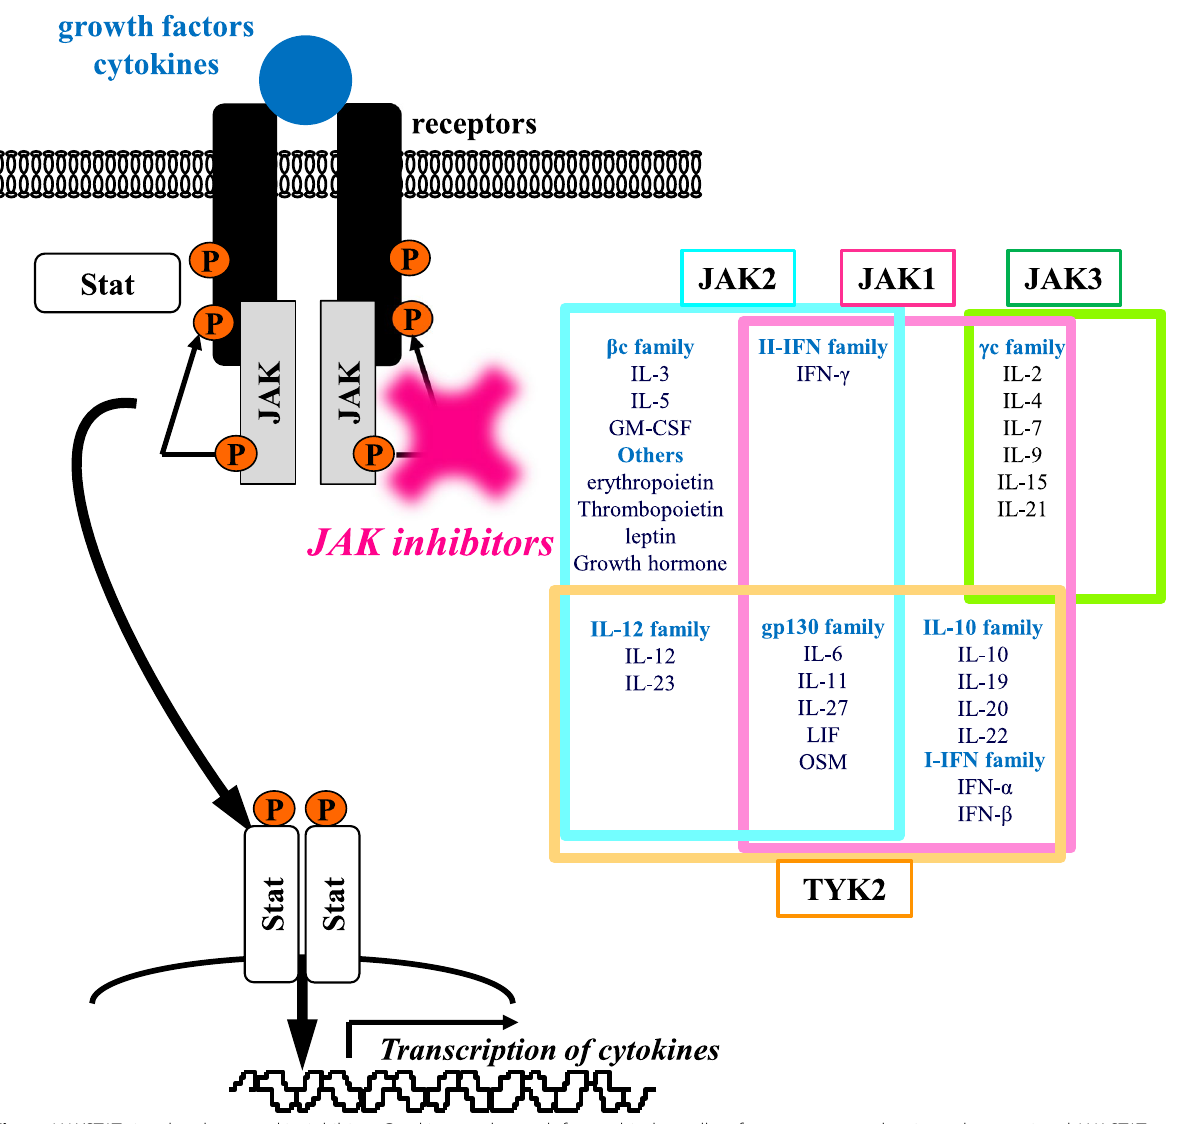
Fig. 1 JAK/STAT signal pathway and its inhibitor. Cytokines and growth factors bind to cell surface receptors and activate the associated JAK-STAT signaling